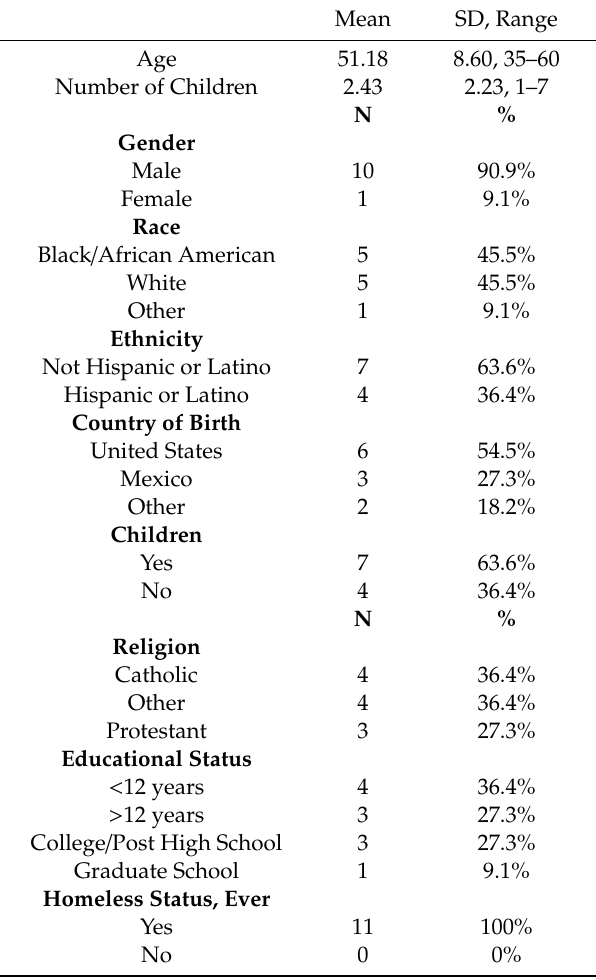
Table 1. Sample characteristics of homeless adults (N =